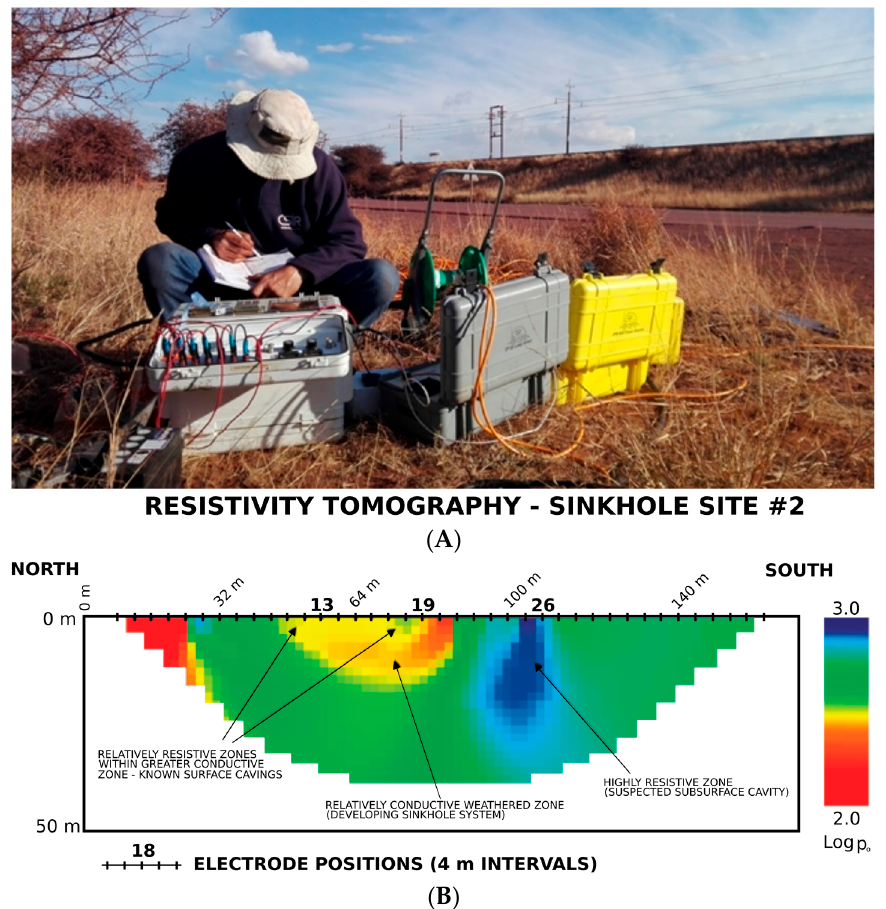
Figure 6. ( A ) The process of ERT data collection; and ( B ) Sample ERT profile indicating the presence of anomalies including a potential cavity and know surface cavings (with permission from [59]).